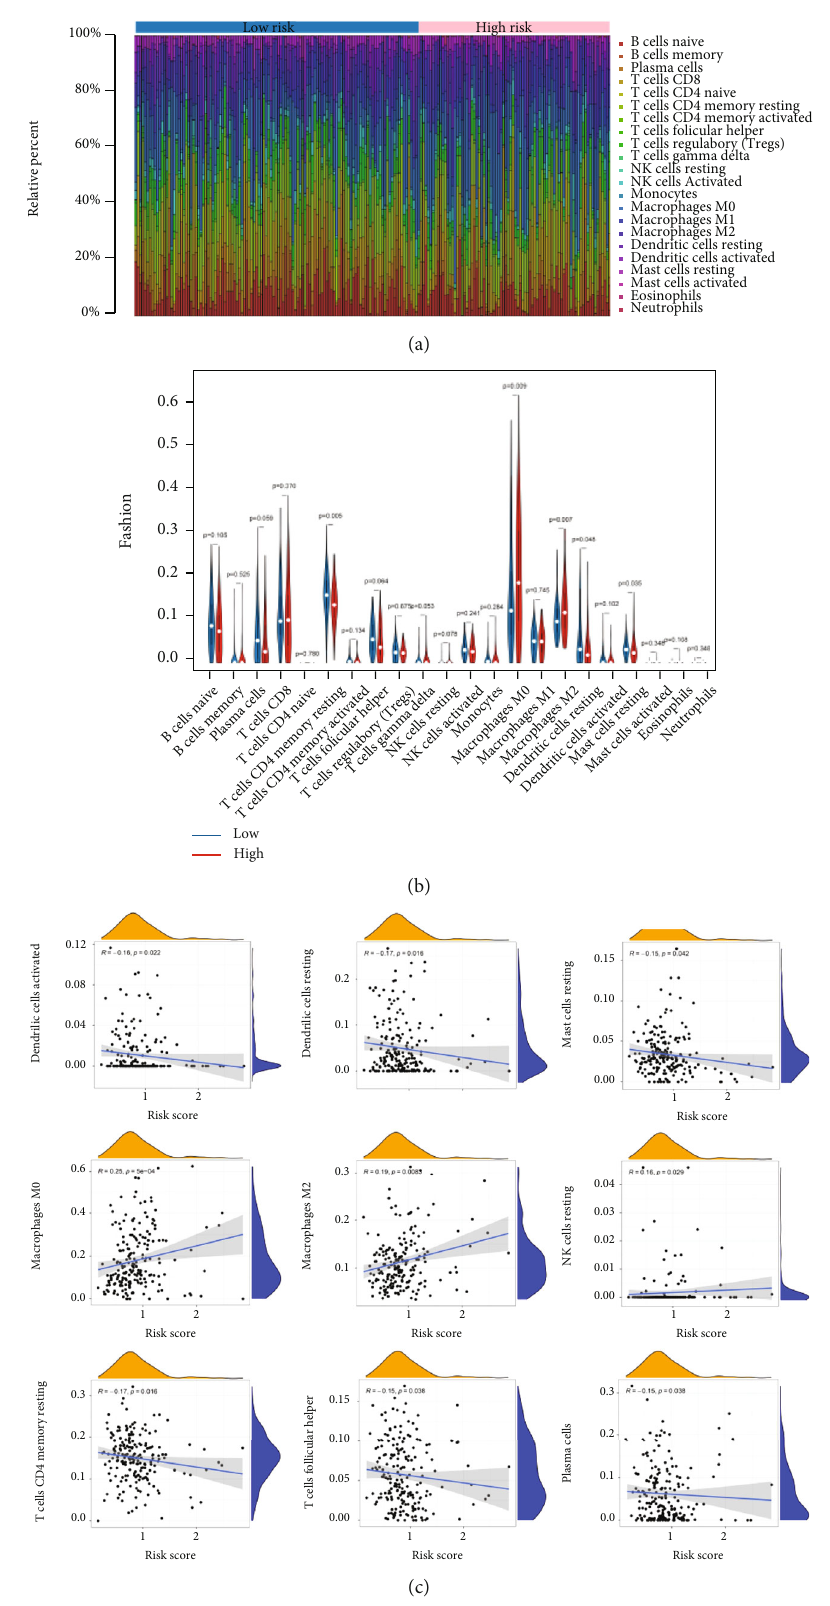
Figure 6: The immune cell in fi ltration landscape in thyroid cancer. (a) Barplot of the tumor-in fi ltrating cell proportions. (b) Violin diagram of the tumor-in fi ltrating cell proportions. (c) Correlation between LPM_score and immune cell